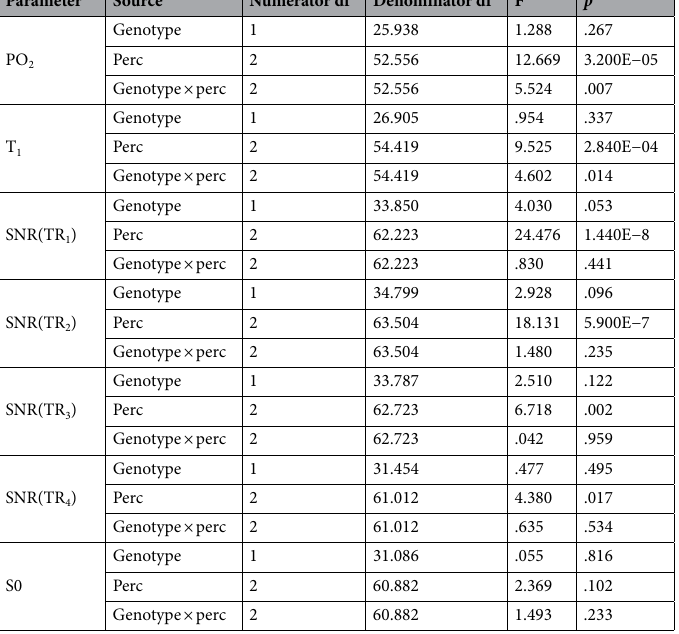
Table 1. Linear mixed-effect modeling including all experimental conditions. Tests of fixed effects (factors genotype and oxygen level) for PO 2 , T 1 , SNR and S 0 . More detailed statistical parameters including estimates can be found in the open data repository.